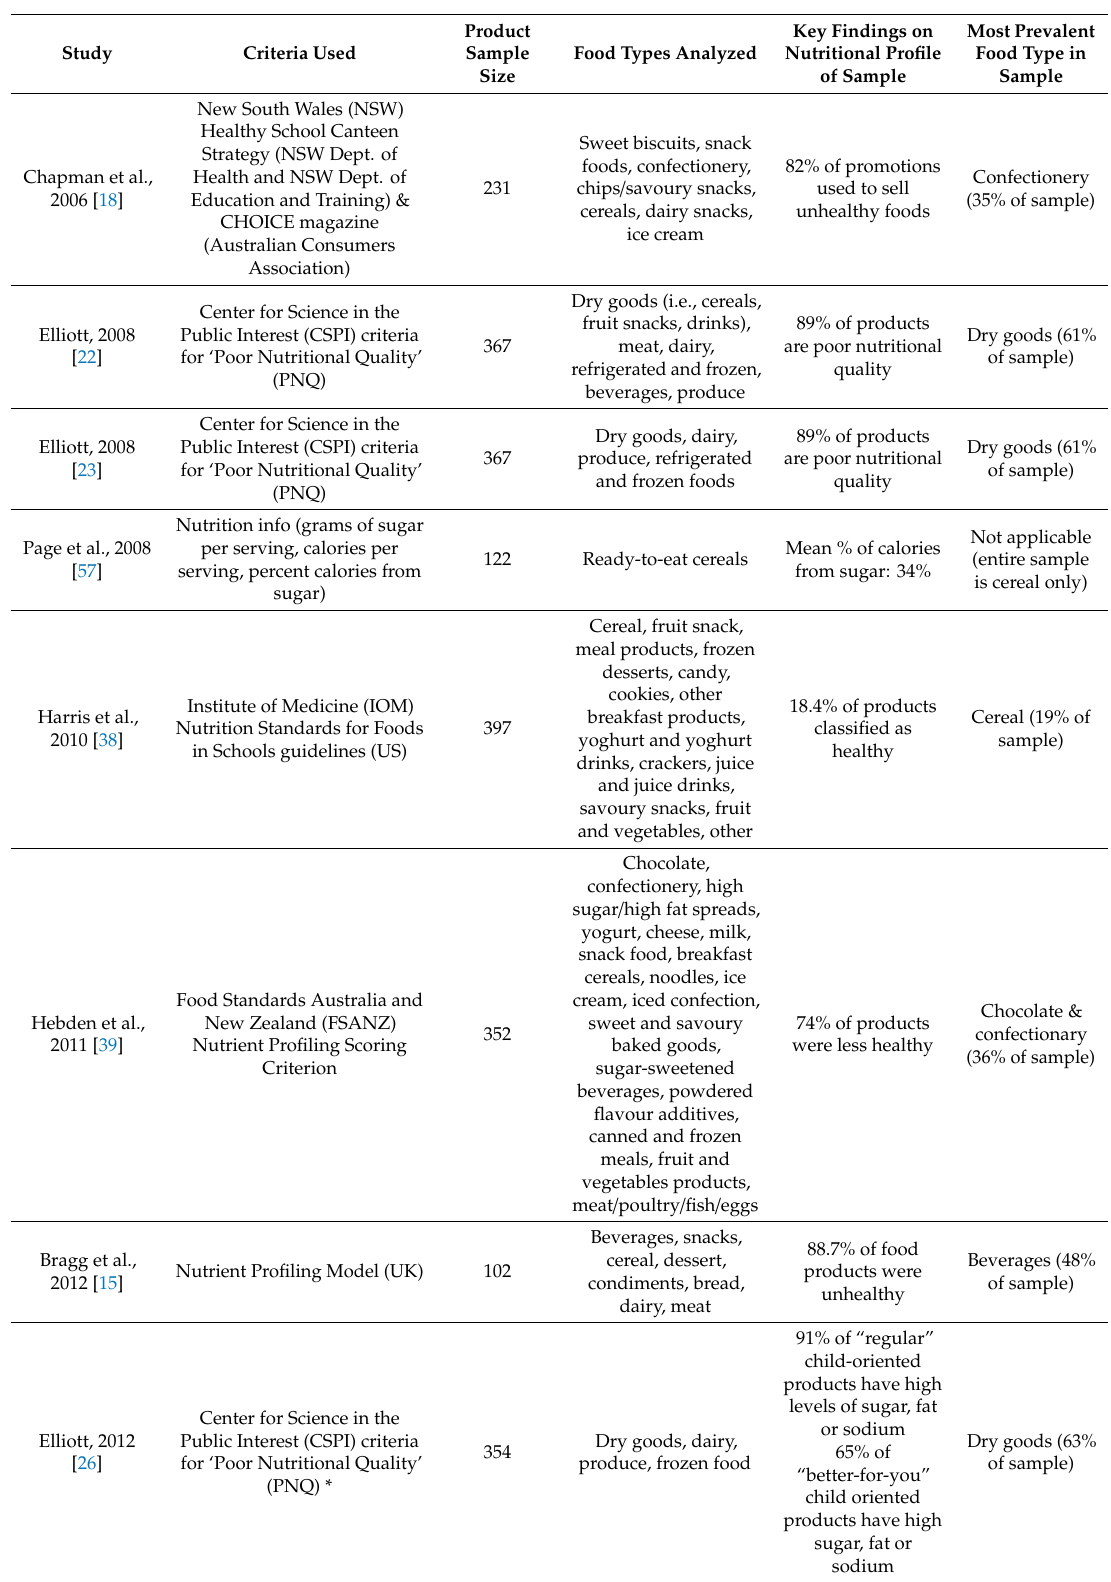
Table 2. Content analyses that use nutrient profiling criteria ( n = 21) and key findings.